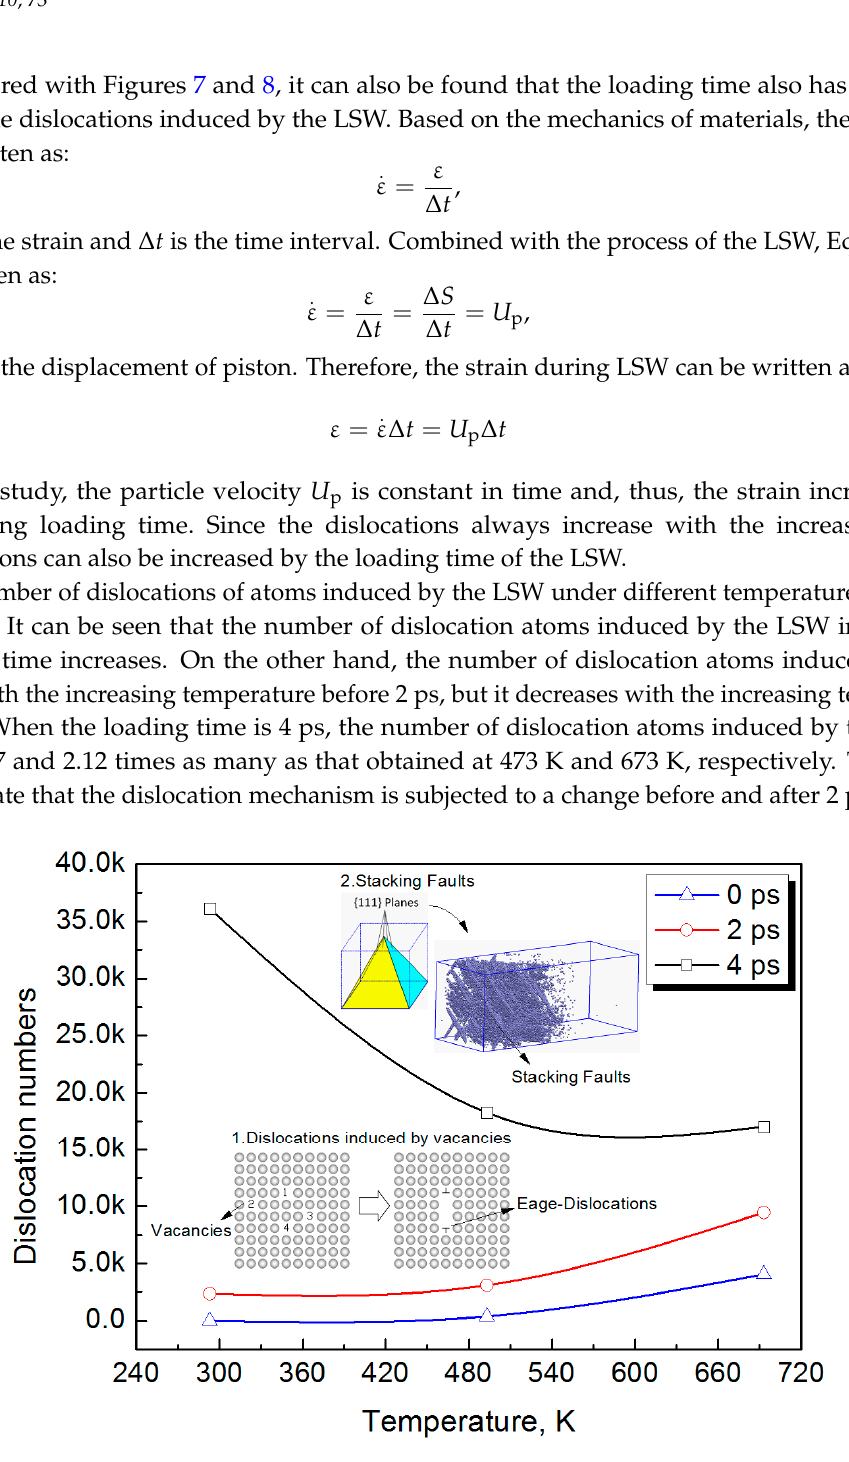
Figure 9. Number of dislocation atoms induced by the laser shock wave under different temperatures.